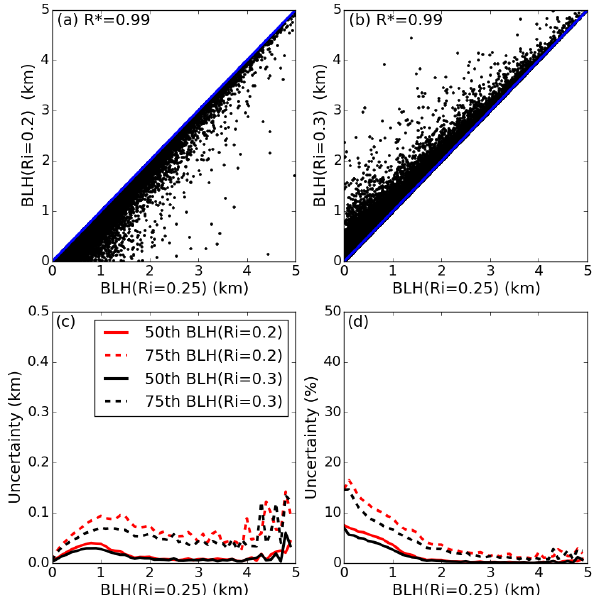
Figure 3. Scatter plots showing (a) CMA-BLHs computed using 0.2 and 0.25 as critical Ri values, and (b) CMA-BLHs computed using 0.25 and 0.3 as critical Ri values, both of which are based on 391552 soundings across China from January 2011 to July 2015. The 50th and 75th percentile values of (c) absolute uncertainty and (d) relative uncertainty using 0.2 and 0.3 as critical Ri values are shown as well. The correlation coefficients ( R ) are given in the top panels, where the star superscripts indicate that values are statisti- cally significant ( p <